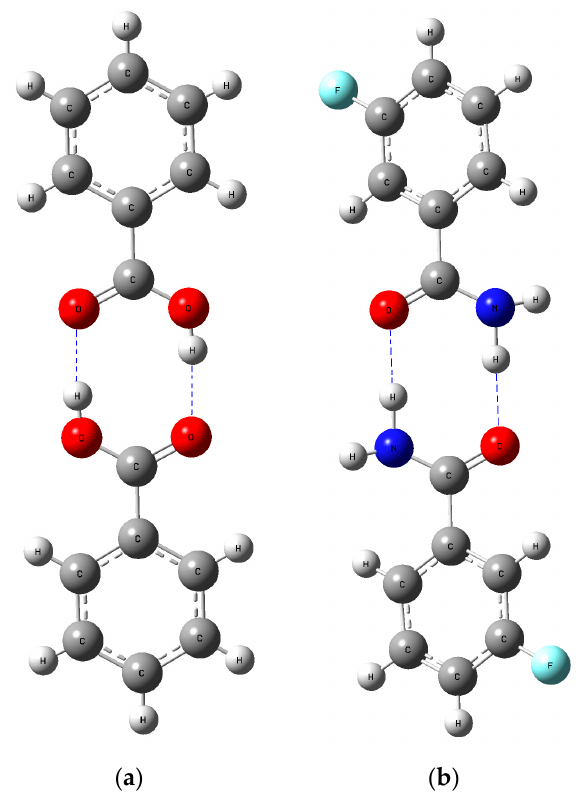
Figure 2. The fragments of the crystal structures of: ( a ) benzoic acid [19] where the dimer is linked by O-H…O HBs; ( b ) m-fluorobenzamide [20] where the dimer is linked by N-H…O HBs. The structures were taken from the Cambridge Structural Database [15]; refcodes: BENZAC02 and BENAFM10, respectively.